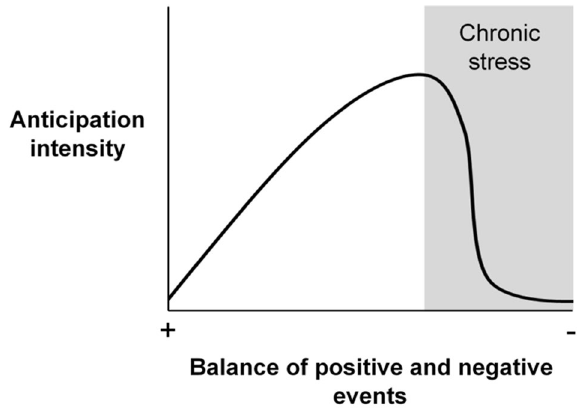
Figure 6. Relationship between the balance of positive and negative events in an animal’s life and anticipation intensity towards individual rewards (adapted from 96